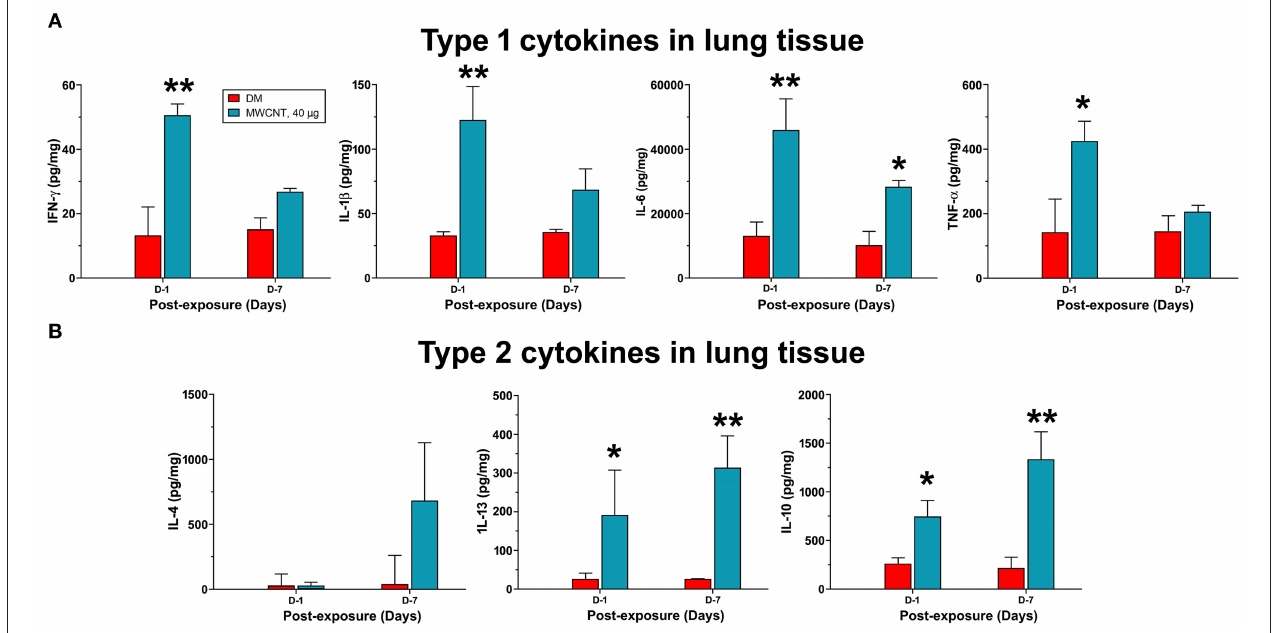
FIGURE 8 | Quantification of type 1 and type 2 cytokines in lung tissue. Mice were treated as described in Figure 2 legend and the lung tissue extract was prepared. Twenty-five microliter of tissue extracts were used for multiplex immunoassays to determine the levels of type I cytokines IFN- γ , IL-1 β , IL-6, and TNF- α (A) , or type II cytokines IL-4, IL-13, and IL-10 (B) . The concentration of each cytokine was presented as pg/mg protein after normalization with the amount of protein used and shown as mean ± SEM ( n = 3). * p < 0.05, ** p < 0.01.